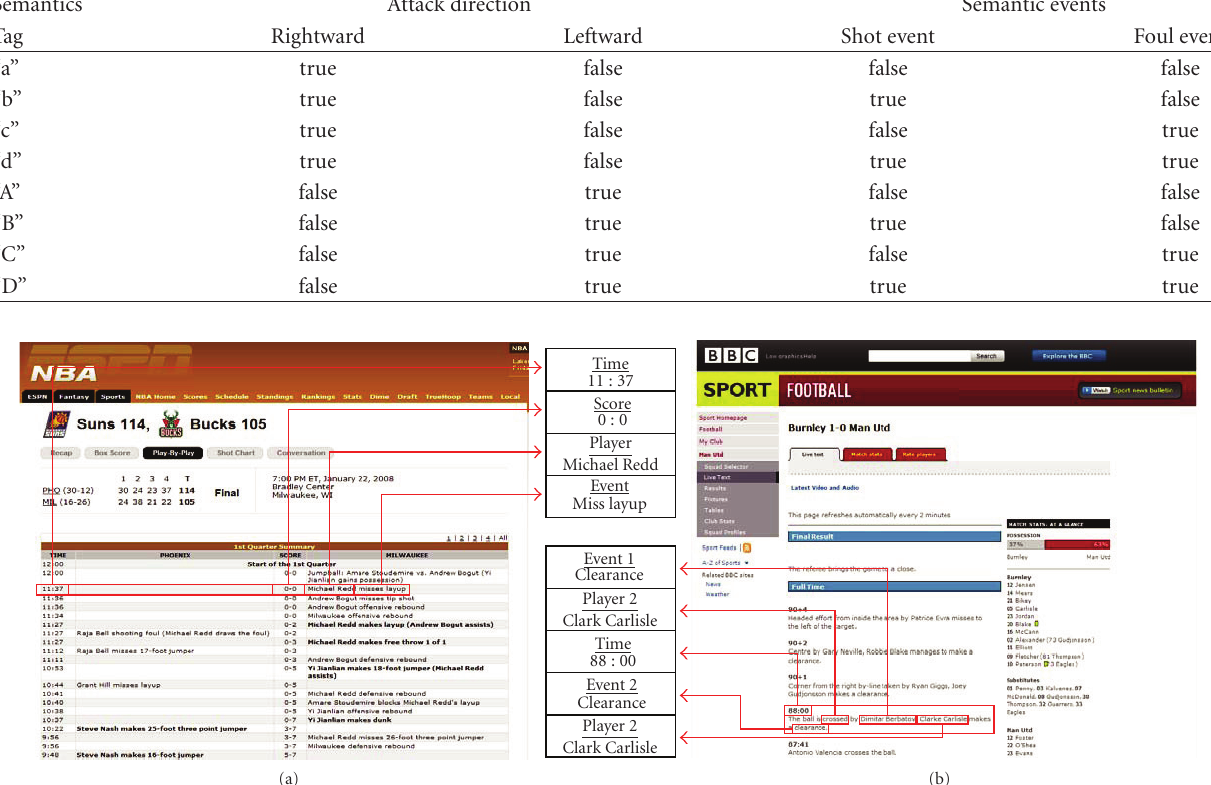
Figure 4: Web-casting text for (a) basketball and (b) football